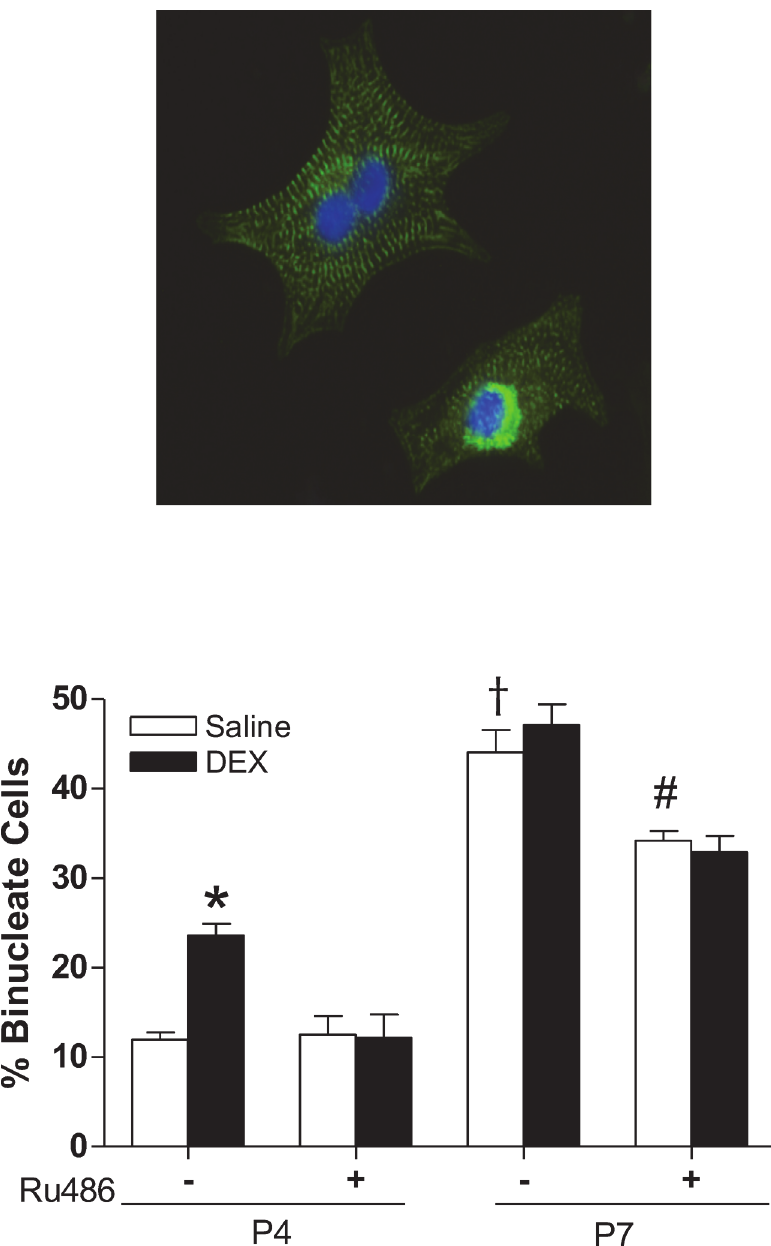
Fig 2. Effect of dexamethasone (DEX) on cardiomyocyte binucleation in neonatal rats. Newborn rats were treated with tapered dose of DEX in the absence or presence of Ru486 during the first three days of postnatal life. Ru486 was administered 30 minutes prior to the DEX treatment. Cardiomyocytes isolated from day 4 (P4) and day 7 (P7) neonatal hearts were stained with α -actinin, and nuclei stained with Hoechst. Representative staining of mononucleated and binucleated cells were shown in the upper panel. Data are mean ± SEM, n = 6 – 14. * p < 0.05, DEX vs . Saline; # p < 0.05, +Ru486 vs .-Ru486; † p < 0.05, P7 vs . P4.